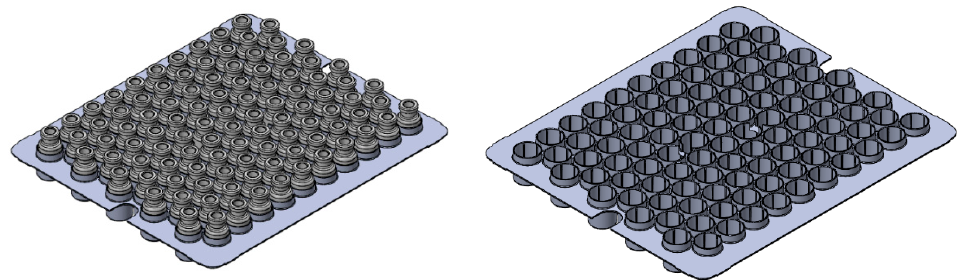
Figure 1. Schematic of the rack system provided by Stevanato Group ( left ) with and ( right ) without